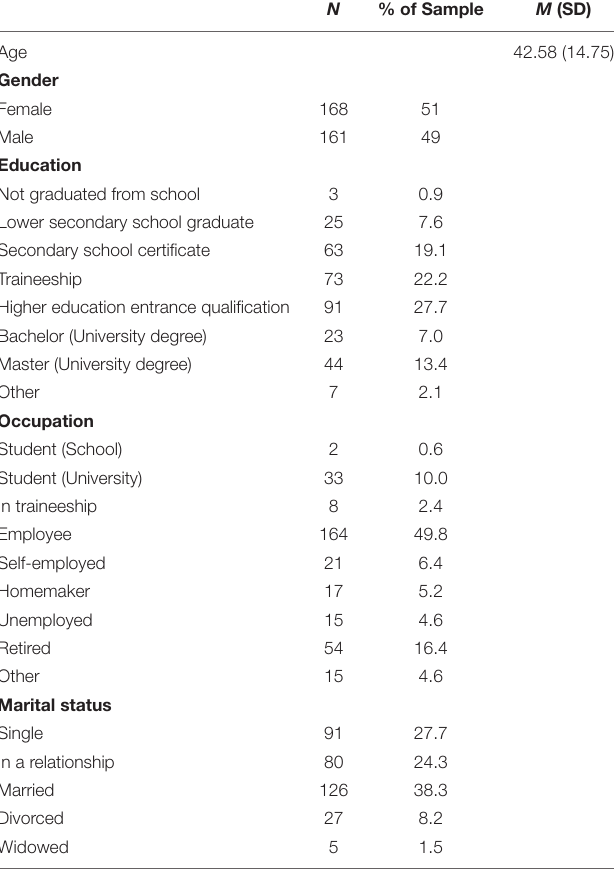
TABLE 1 | Socio-demographic details on